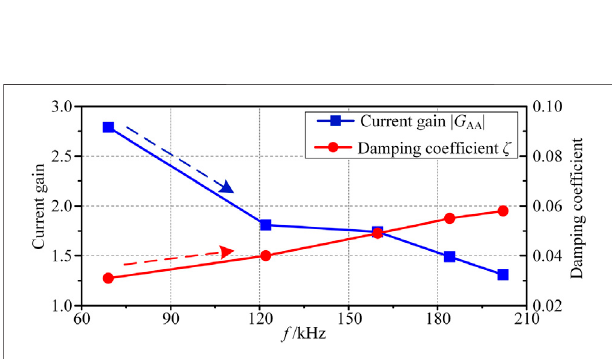
FIGURE 10 | Variation trends of current gain | G AA | and damping coef fi cient ζ .